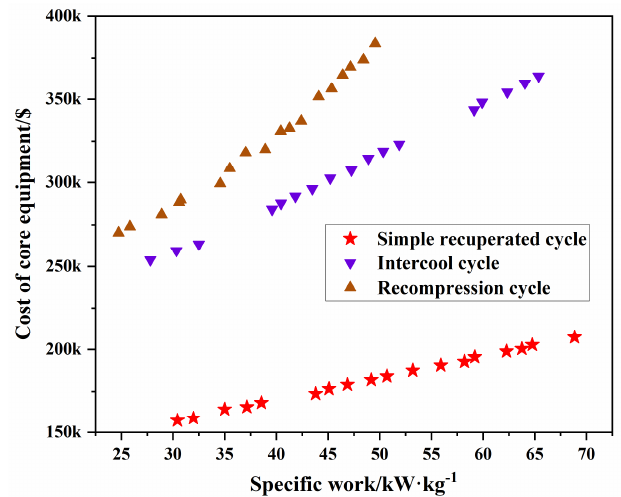
Figure 13. Comparison of Pareto sets for three